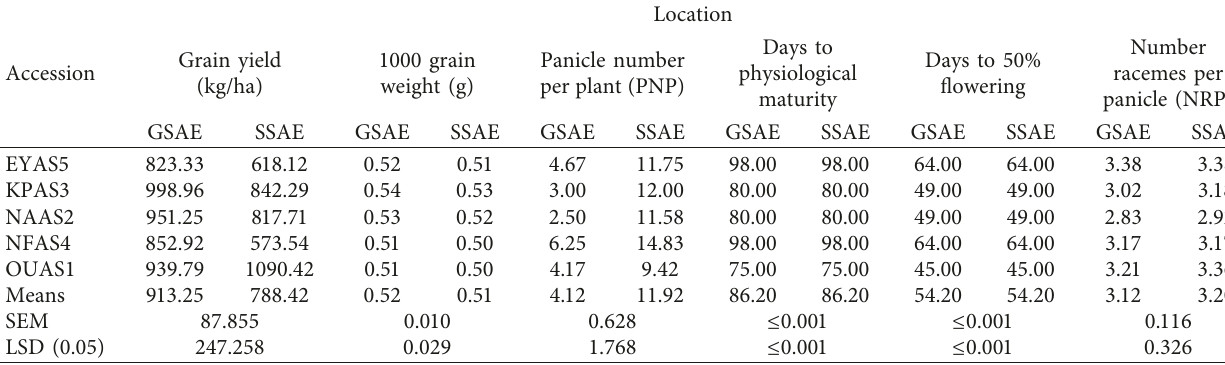
SEM � Standard error of means. Table 7: Influence of accession X location interaction on yield and yield components.